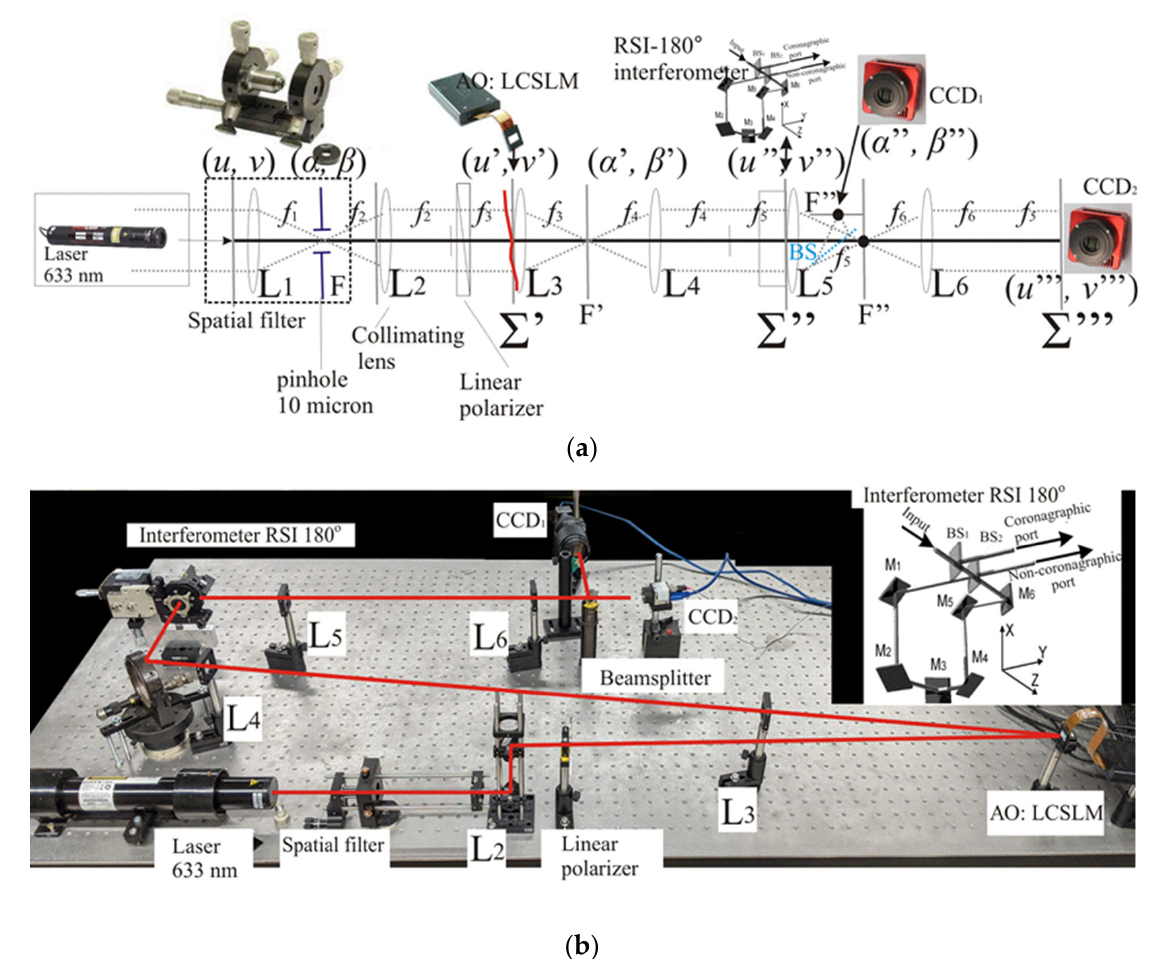
Figure 7. Optical scheme ( a ) and photo ( b ) of the lab experiment for wavefront correction with measurement of wavefront distortions after an interfero-coronagraph. Marked: laser , spatial filter : L 1 lens , L 2 collimating lens , linear polarizer , phase-only LC SLM (LC SLM shown in the in the transmitting mode in panel ( a )), interfero ‐ coronagraph ( AIC ‐ 180° ) (shown in enlarged size in tab ( b )), beam splitter , focusing lenses L 3 – L 5 , CCD 1 (field camera in focal plane), focusing lens L 6 to form a pupil plane, CCD 2 (camera in pupil plane).